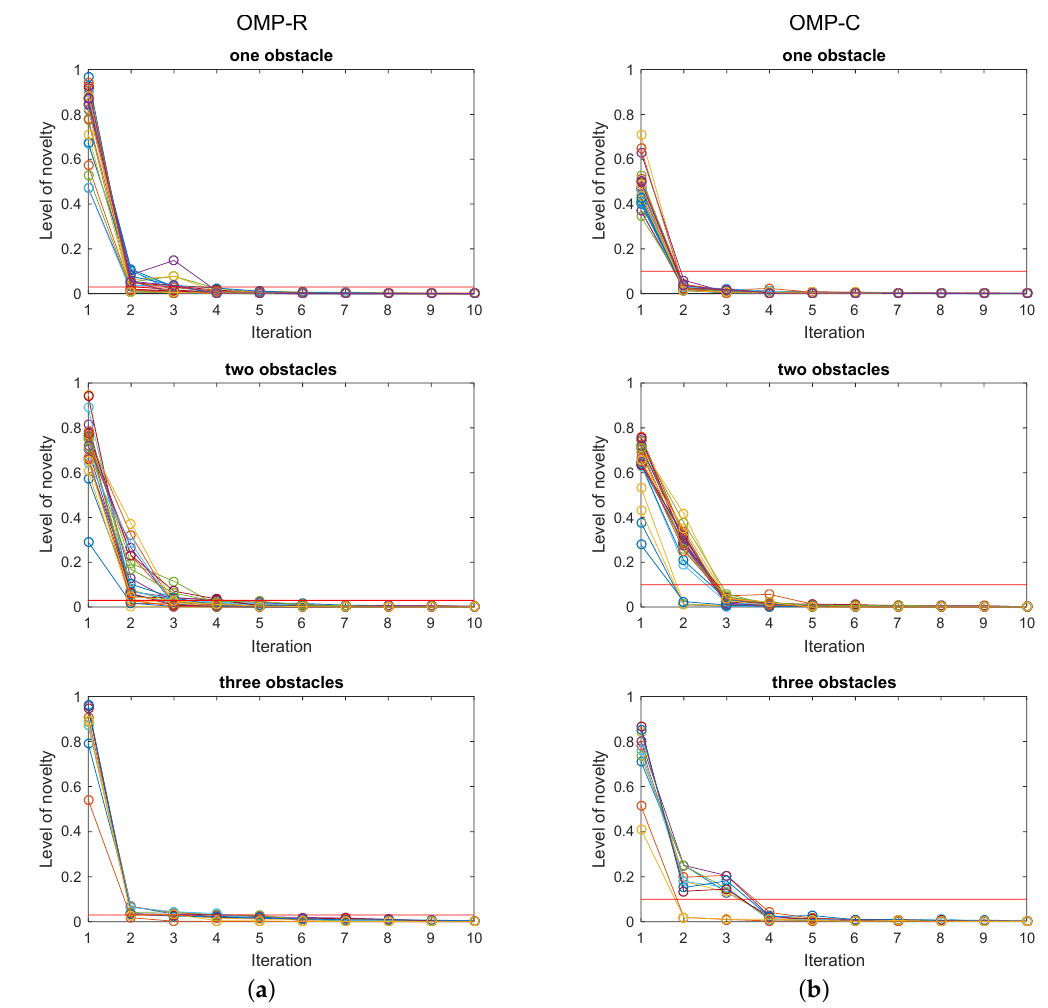
Figure 6. Level of novelty in 10 iterations for all OMP reconstructions: ( a ) corresponds to real-valued model results, and ( b ) to complex-valued model results. The red line corresponds to the chosen novelty levels, 0.03 for OMP-R and 0.1 for